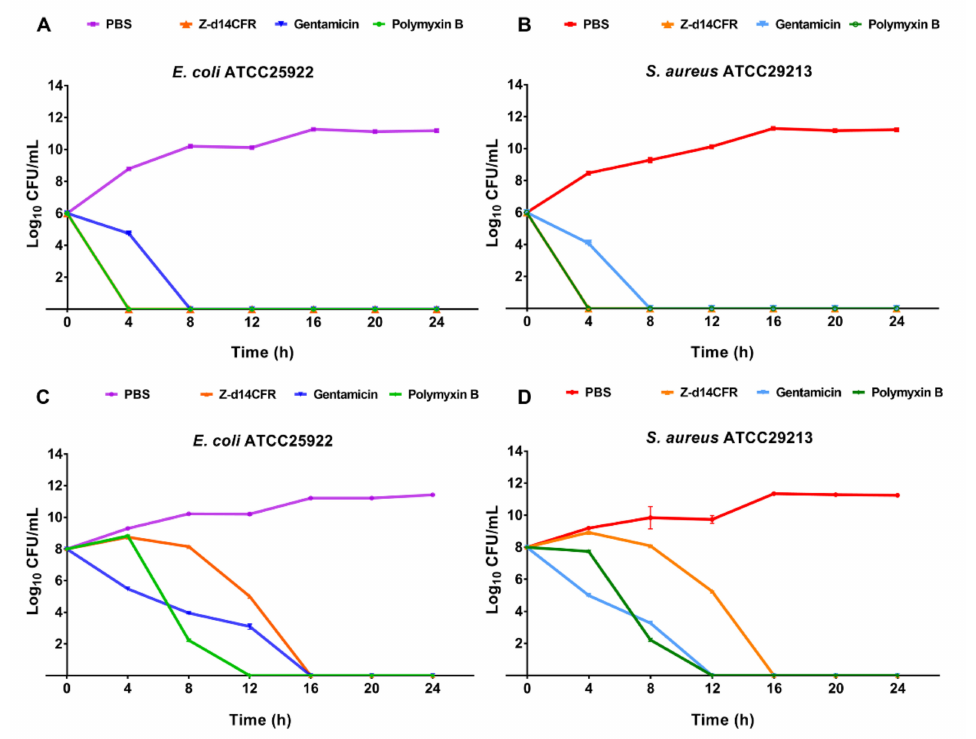
Figure 4. Time-killing curves of Z-d14CFR. Bacterial count of E. coli ATCC25922 ( A ) and S. aureus ATCC29213 ( B ) in logarithmic phase incubated with 2 MIC Z-d14CFR, polymyxin B or gentamicin. Bacterial count of E. coli ATCC25922 ( C ) and S. aureus ATCC29213 ( D ) in plateau incubated with 2 MIC Z-d14CFR, polymyxin B or gentamicin. The results are represented as mean ± SEM from three independent